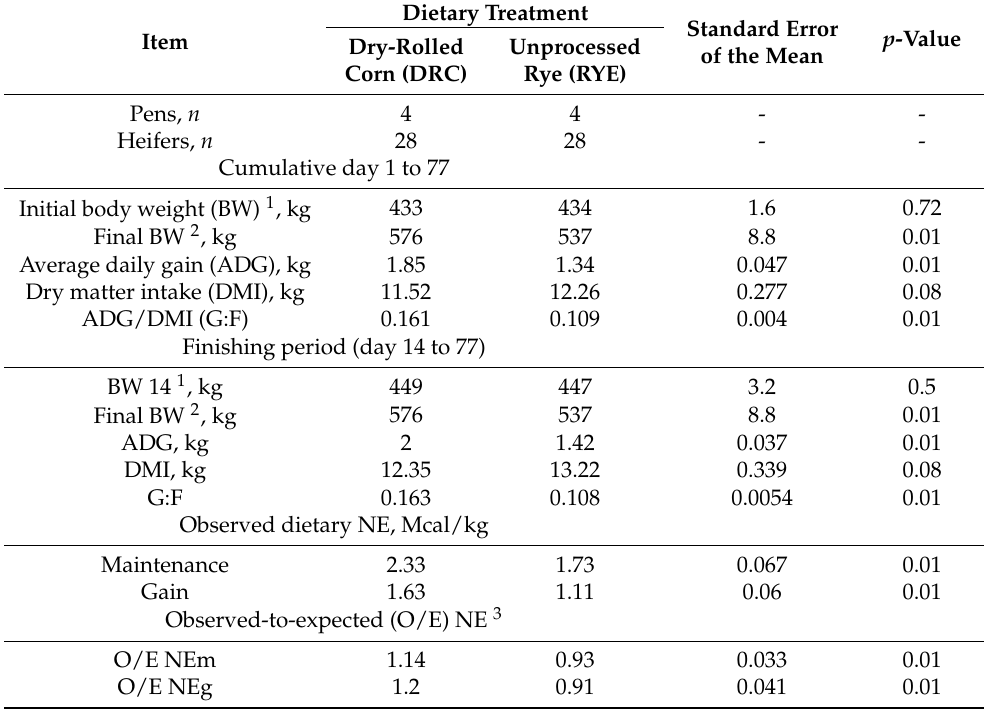
Table 2. Growth performance responses and efficiency of dietary net energy (NE)